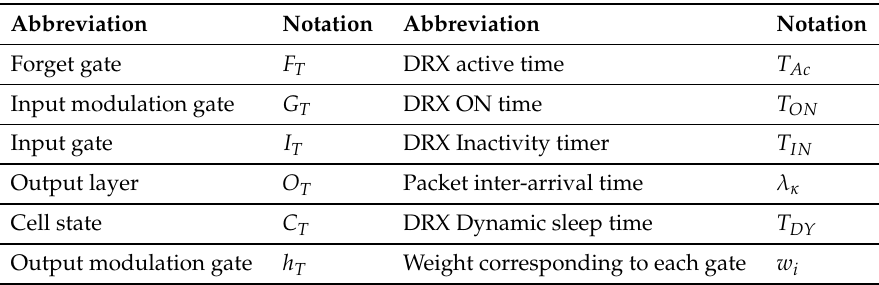
Figure 4. Gated structure of single long short-term memor (LSTM) unit. Table 1. List of